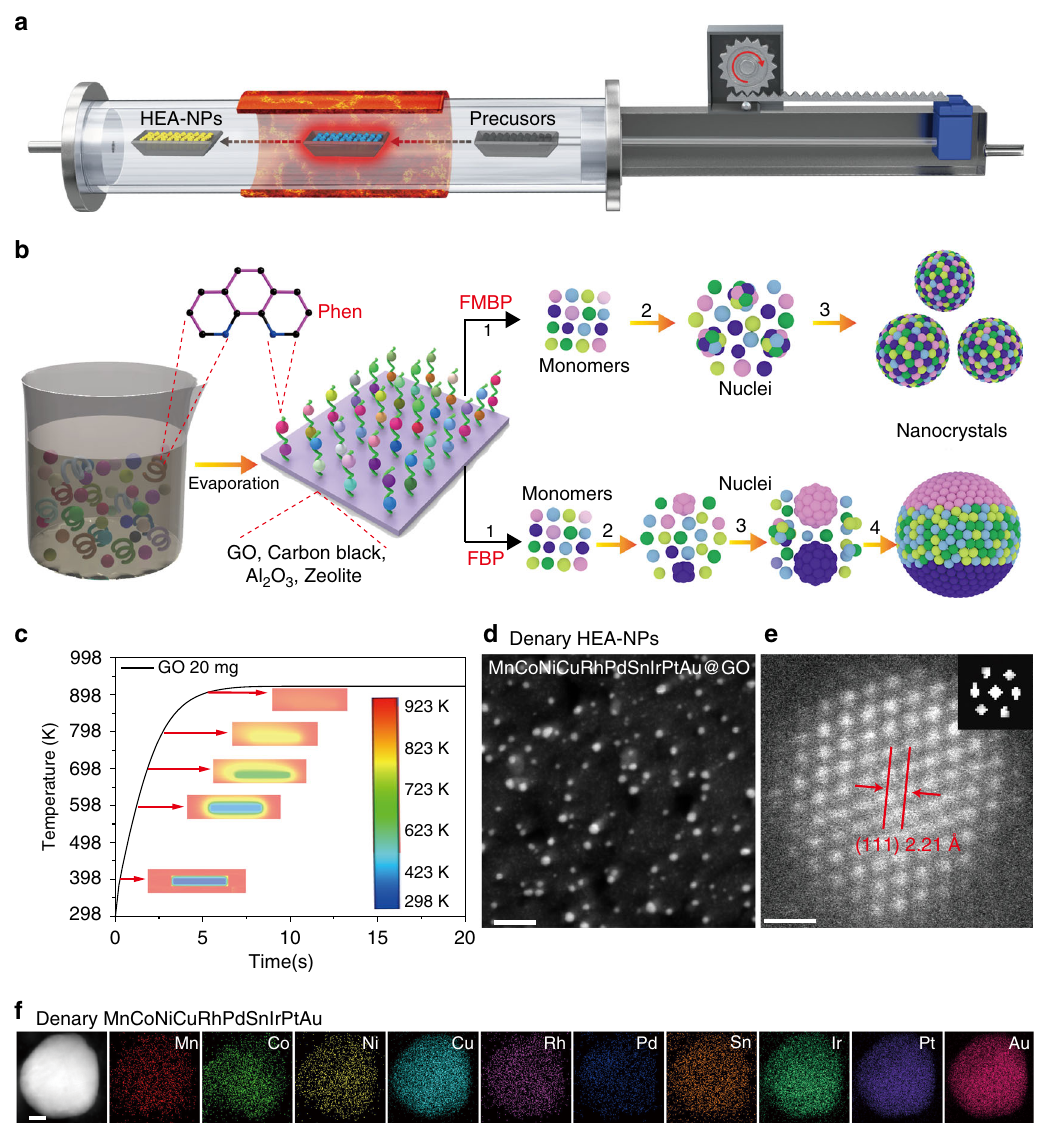
Fig. 1 The FMBP strategy for synthesis of HEA-NPs. a Schematic diagram of the FMBP experimental setup for synthesis of HEA-NPs. b Schematic diagrams for synthesis of homogeneous and phase-separated HEA-NPs by FMBP and FBP strategies, respectively. c The simulation of the time required for precursors/GO (20 mg, 3 wt%) to reach 923 K in the FMBP process. Center: the metal precursors/GO in the quartz boat. d HAADF-STEM images for the denary (MnCoNiCuRhPdSnIrPtAu) HEA-NPs highly dispersed on GO synthesized by the FMBP strategy (The loading of HEA-NPs on GO was 3 wt%). e The HR-STEM image for the denary (MnCoNiCuRhPdSnIrPtAu) HEA-NPs (inset, the Fourier transform analysis for denary (MnCoNiCuRhPdSnIrPtAu) HEA-NPs indicated that the denary HEA-NPs featured with an fcc crystal framework). f Elemental maps for denary (MnCoNiCuRhPdSnIrPtAu) HEA-NPs (The loading of HEA-NPs on GO was 10 wt%). The elements in HEA-NPs have the equal atomic ratio. Scale bar d : 10 nm, e : 0.5 nm, and f : 10